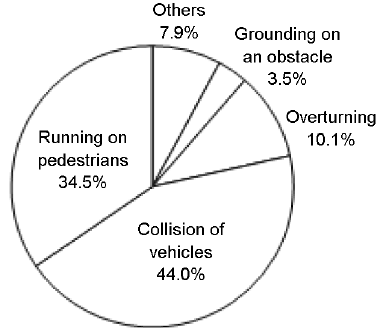
Fig. 3. The percent distribution of traffic accidents in Lithuania in 2011 (total number of registered accidents – 3312)